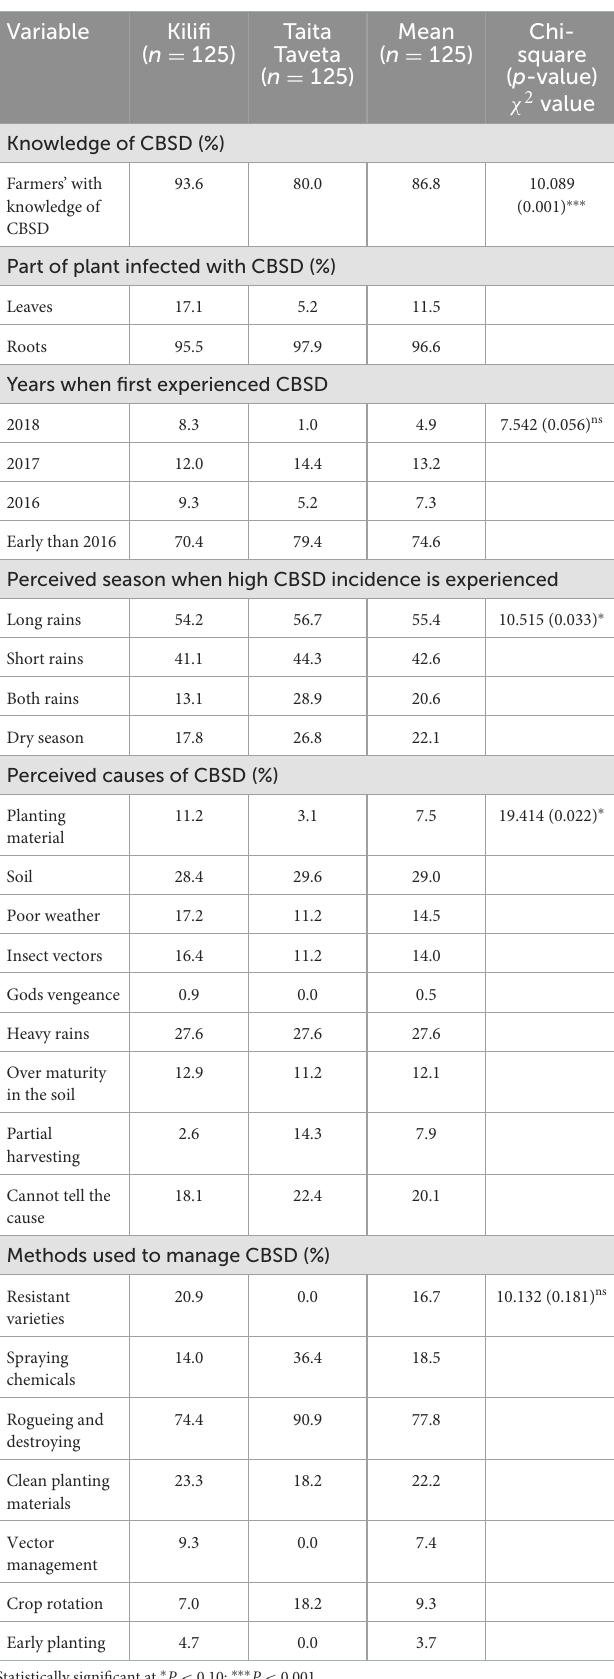
TABLE 5 Analysis of association between farmers’ awareness on levels of CBSD and socio-economic factors. Chi- square